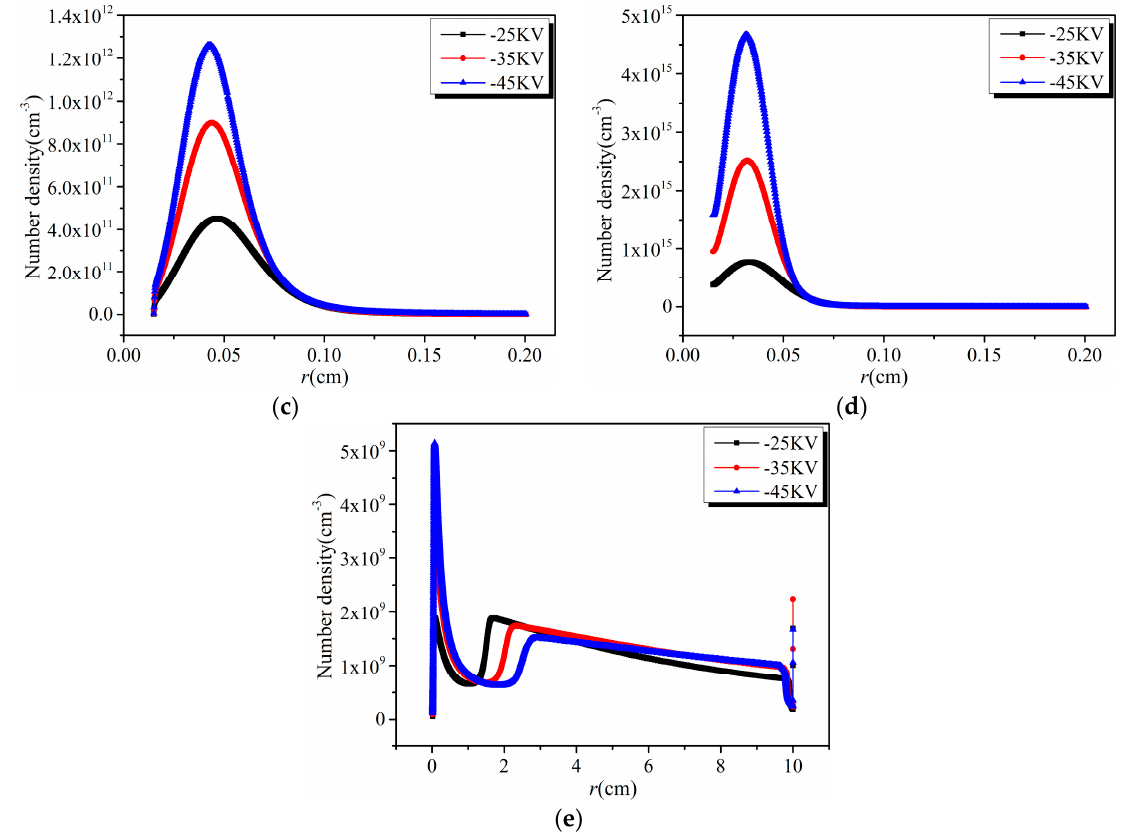
Figure 6. Effect of discharge voltage on the number densities of active particles and electrons: ( a ) O; ( b ) O( 1 D); ( c ) N 2 (A); ( d ) N; and ( e ) e .